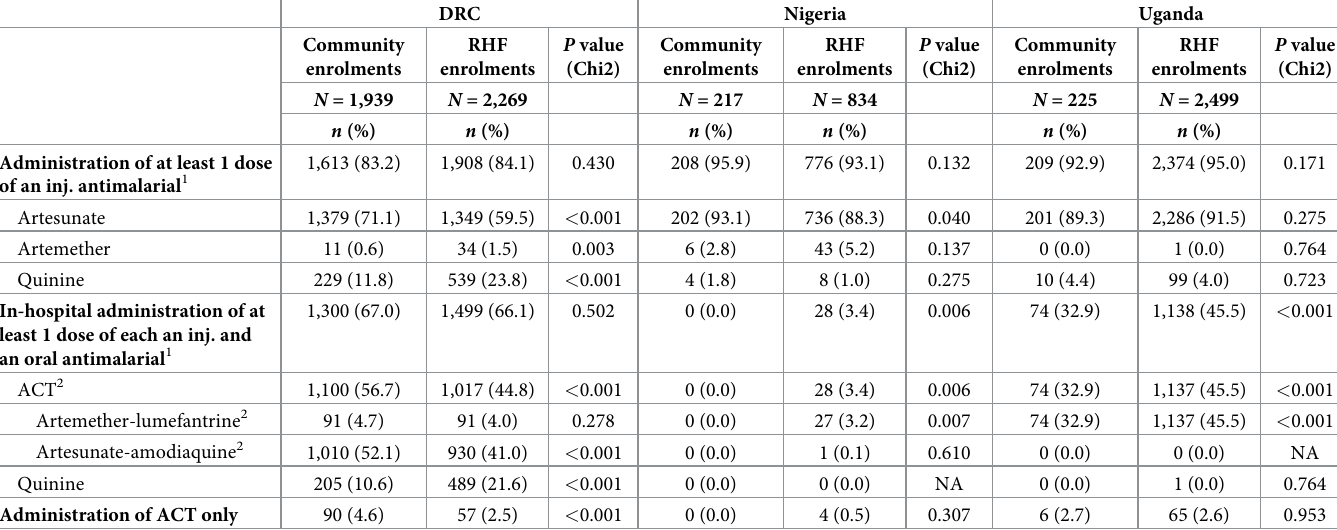
Table 2. Administration of antimalarial treatment for severe malaria, by country and enrolment level.